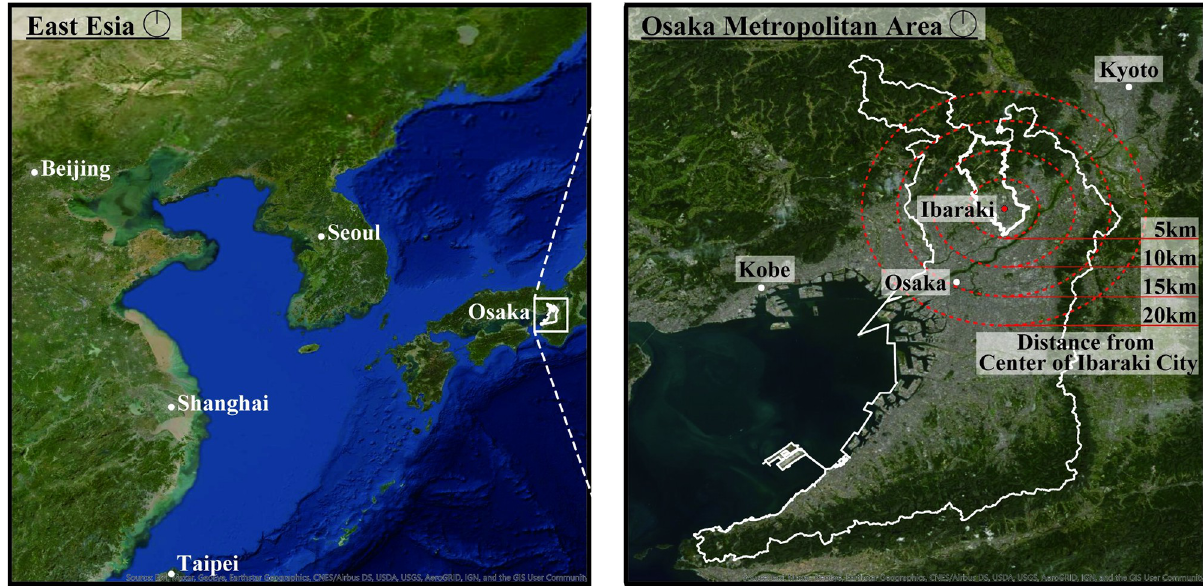
Fig 1. Locations of Osaka Prefecture and Ibaraki City. The thin lines indicate the location of Osaka Prefecture, and the thick lines indicate the location of Ibaraki City. The red point is the central area of Ibaraki City, where the Ibaraki City Government Hall is located. The red dotted circles indicate the distance from the center of Ibaraki City. The distances are 5 km, 10 km, 15 km, and 20 km.